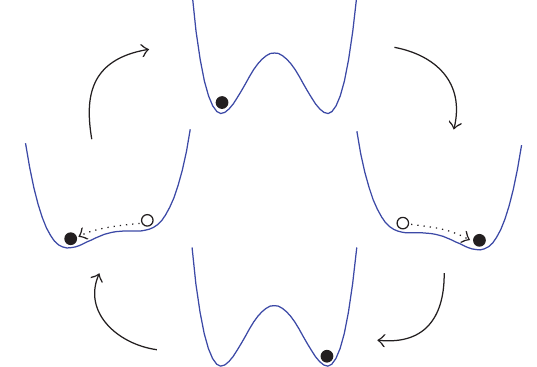
Figure 2: State transition of Duffing oscillator system with the assistance of periodic force and